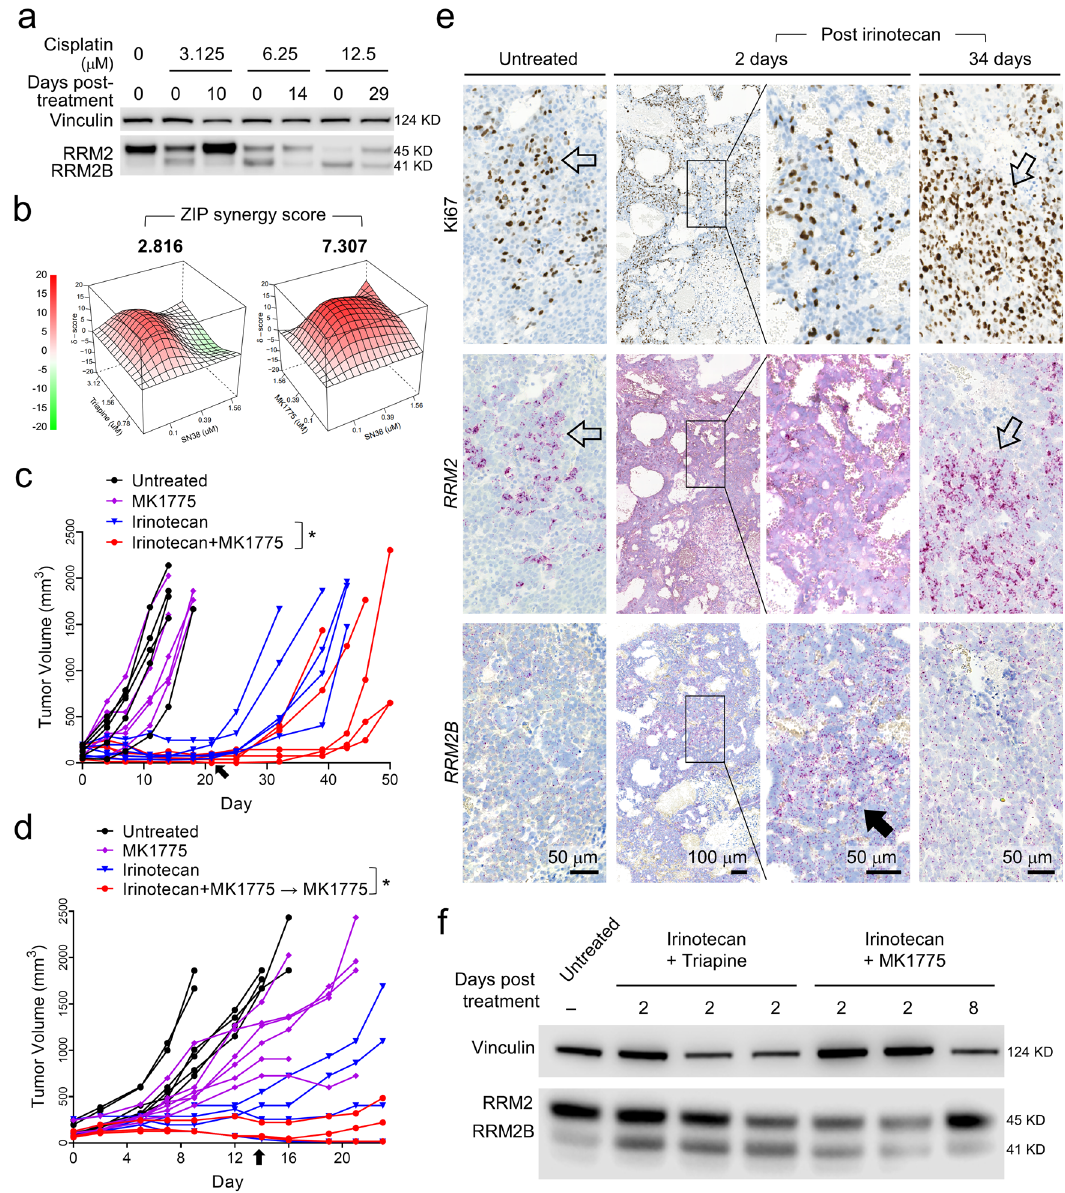
Fig. 7 A reversed RRM2B-to-RRM2 subunit switching in HB cells during post-drug treatment regrowth can be targeted to delay HB tumor relapse in vivo. a RRM2 and RRM2B immunoblotting using HepG2 cells recovered from the indicated cisplatin treatment. b ZIP synergy analysis of the two RRM2 inhibitors in combination with SN38 in HB214 cells. c Tumor volume measurements in mice treated with the indicated drug or drug combination. Arrow: drug withdraw on Day 21. d Tumor volume measurements in mice treated with the indicated drug or drug combination. Arrow: drug withdraw on Day 14. MK1775 was maintained in the last group (red line). e Ki67 IHC and RRM2 and RRM2B RNAscope in untreated HB214 tumors and those two days and 34 days post irinotecan treatment. Open arrows: co-localization of Ki67 + and RRM2 + cells in untreated and relapsed HB214 tumors; solid arrow: transient increase in RRM2B expression in HB214 tumors two days post irinotecan treatment. Images on the same column share the same scale bar. f RRM2 and RRM2B immunoblotting of the HB214 tumors collected post the indicated treatment. Extra Sum of Square F test was performed for ( c , d ). P value, *